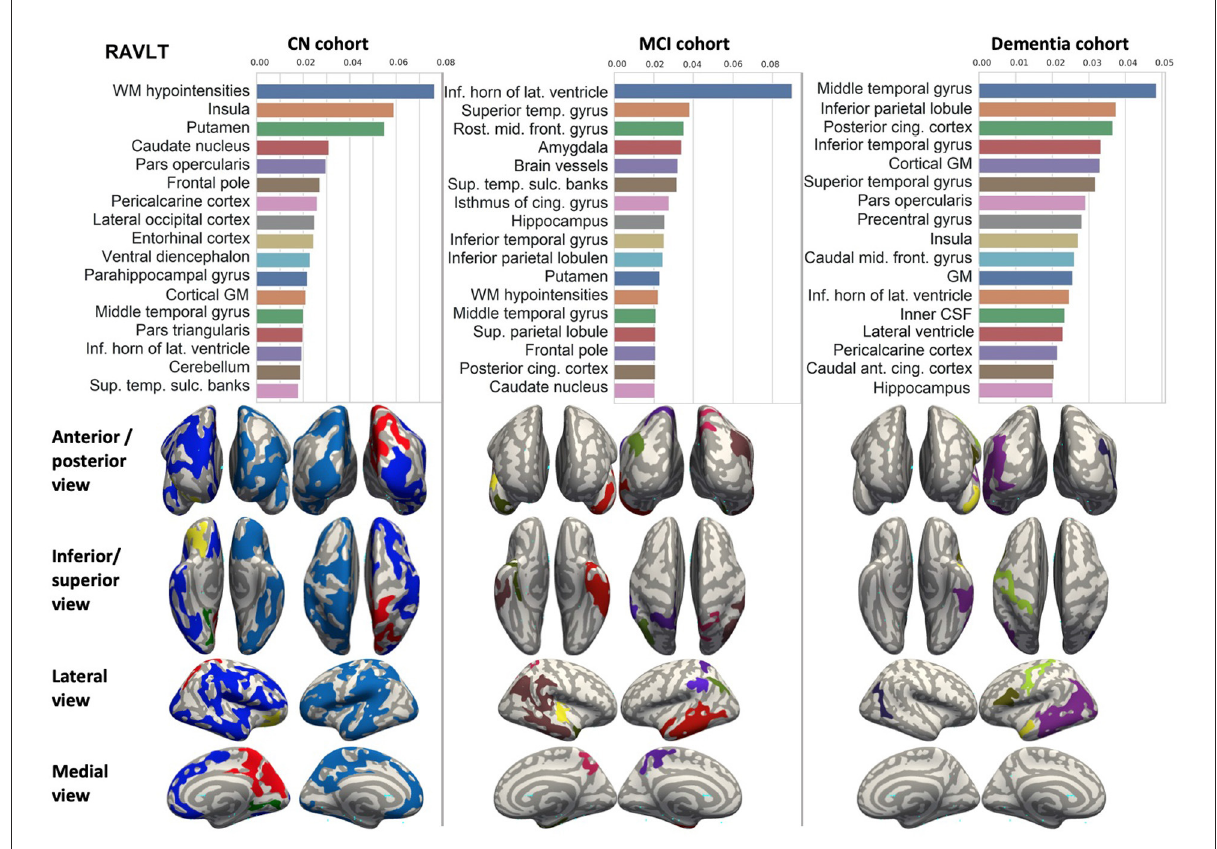
FIGURE5 Brain structures ranked according to information gain value for RAVLT score prediction. Inflated cortical representations showing significant correlations between cortical volumes and test